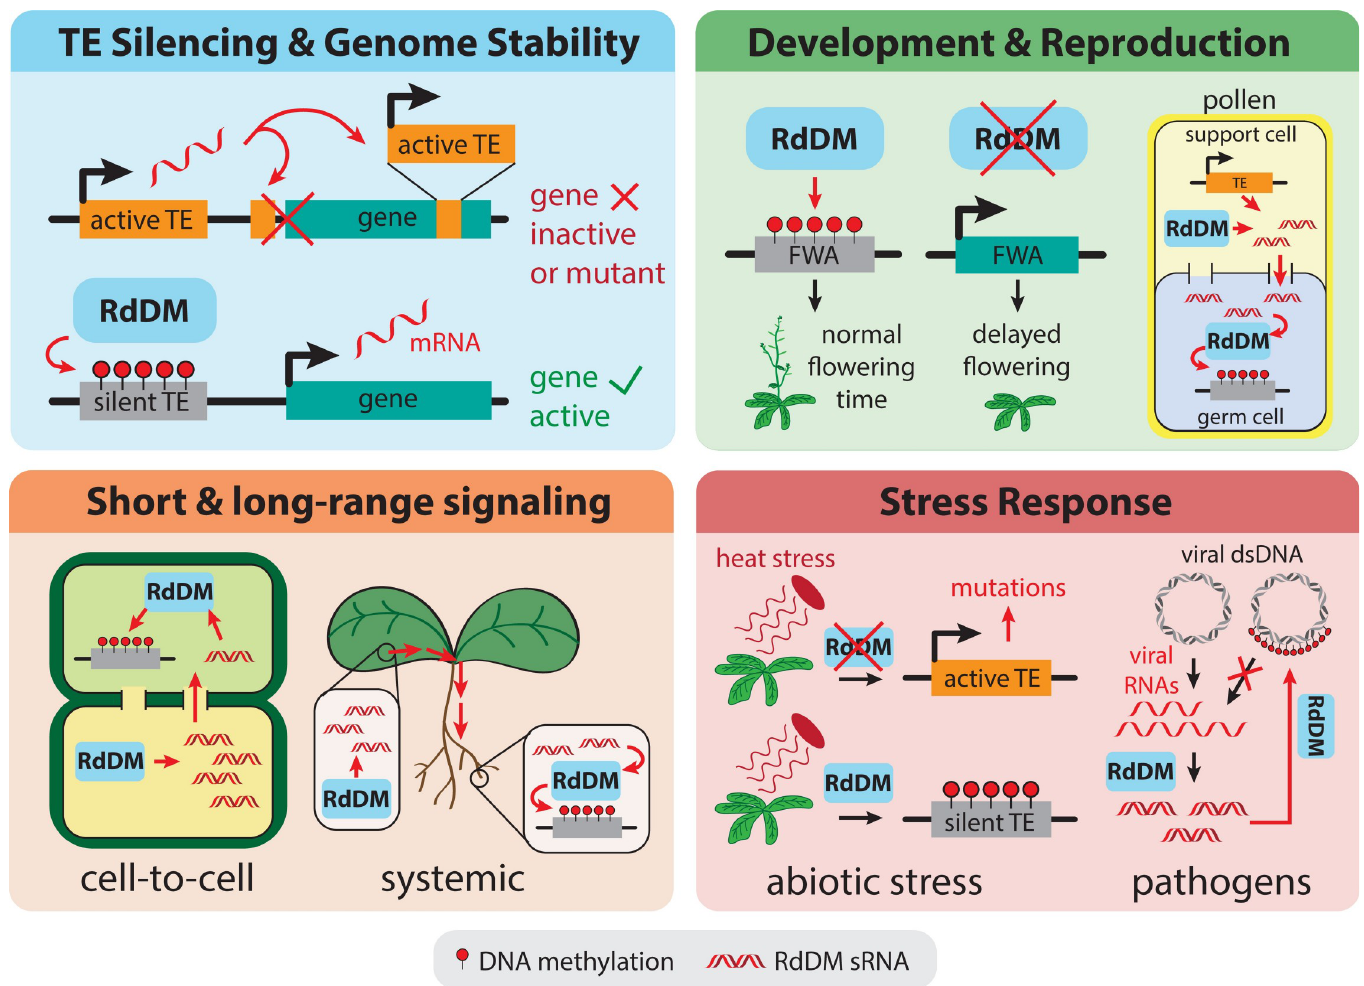
Fig 1. High level overview of several of the biological functions of RdDM. Top left: TE silencing by RdDM prevents TE activation and transposition. Without RdDM, active TEs are free to transpose into genes or promoters, which can disrupt gene expression or result in a mutant protein. Top right: RdDM is involved in several aspects of development; for example, RdDM affects flowering time by repressing FWA. In pollen, TEs become activated in a support cell, leading to the production of sRNAs for RdDM that move to the germ cell in order to reinforce TE silencing. Bottom left: sRNAs involved in RdDM are mobile, and can move between cells through plasmodesmata or systemically via the vasculature, so RdDM-mediated silencing can spread from its point of origin to distal tissues. Bottom right: RdDM is involved in several abiotic stress responses including the heat shock response, and can silence TEs that would otherwise become active and transpose under heat stress. RdDM is also involved in pathogen defense, and can silence viral DNA (either as a viral minichromosome, shown, or as an integrated provirus) using sRNAs derived from viral mRNAs.